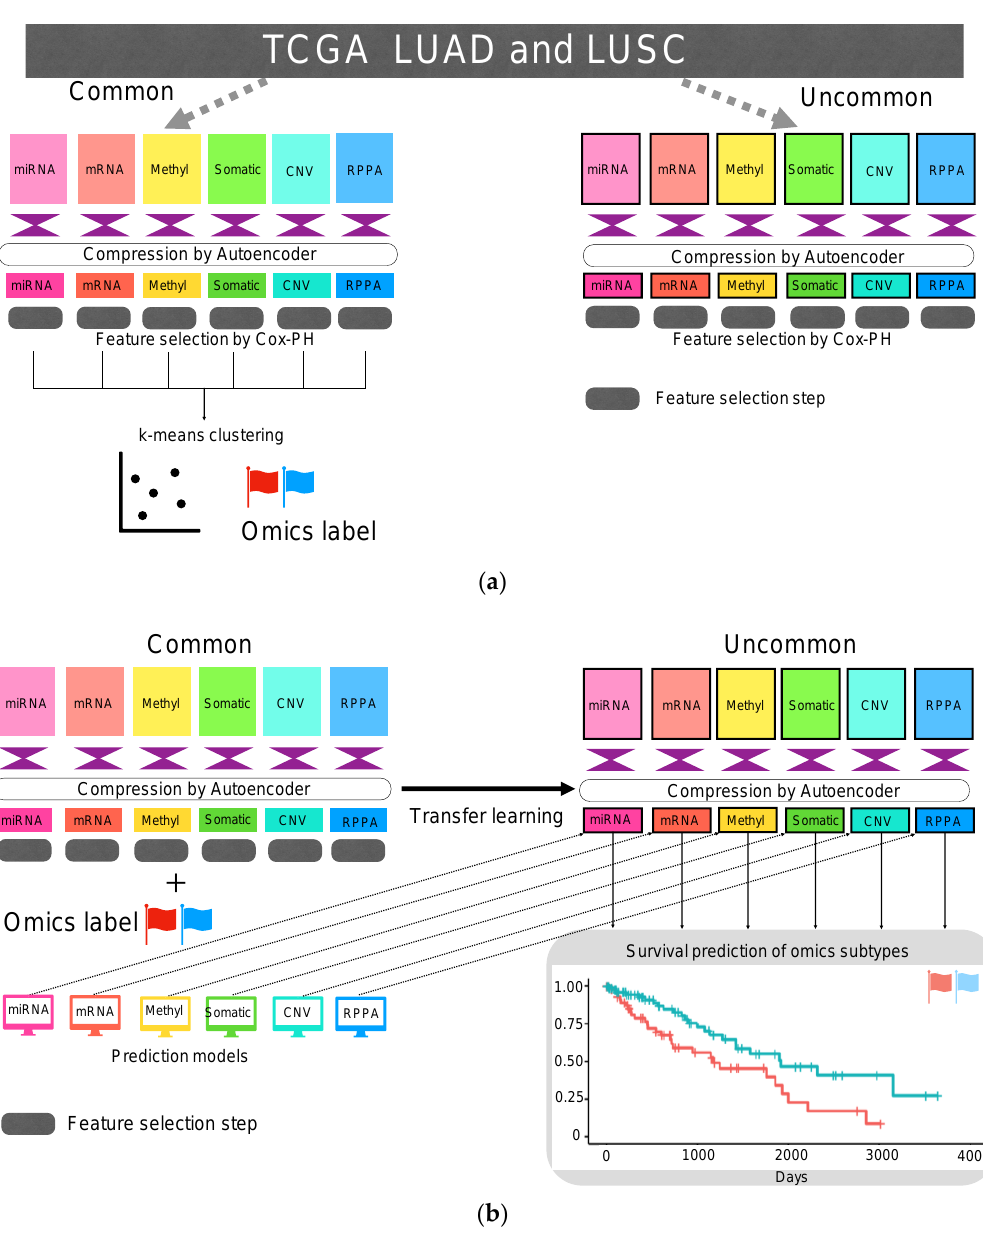
Figure 1. Overall workflow of the study. ( a ) Detecting integration survival subtypes in non-small cell lung cancer (NSCLC) from six categorical multi-omics data in The Cancer Genome Atlas (TCGA). An autoencoder and unsupervised learning technique were used. ( b ) Prediction of integration survival subtypes using only one categorical data and the validation of the model using uncommon data.